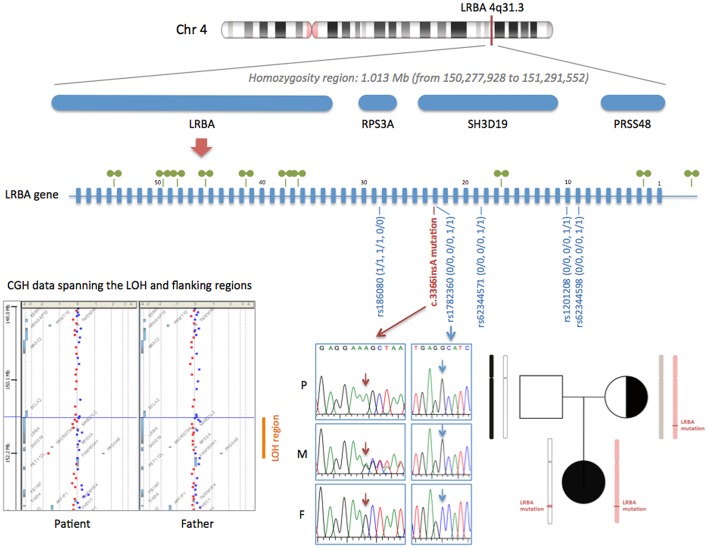
Segmental isodisomy of maternal origin containing the c.3366insA LRBA mutation. The LOH region in chromosome 4 of the patient is indicated by a red line. The LOH region, detected by analyzing WES data, includes four genes (LRBA, RPS3A, SH3D19, and PRSS48). A diagram of the LRBA gene with its 58 exons is shown. The 10 CGH array probes located along the LRBA gene are depicted with green symbols. All LRBA probes displayed a normal signal, confirming a copy number-neutral region. The c.3366insA mutation is shown in red (electropherograms of the patient and her parents). Five common SNPs surrounding the LRBA mutation are also shown in blue. The genotype of the patient (P) and her mother (M) and father (F) are indicated using the numbers 0 and 1 for the 2 possible alleles. Array-CGH data spanning the LOH and flanking regions is shown. gDNA from patient and father was labeled with Cy3 (red) and control gDNA with Cy5 (blue). The pedigree of the family shows the inherited chromosome 4, with the segmental isodisomy of maternal origin.